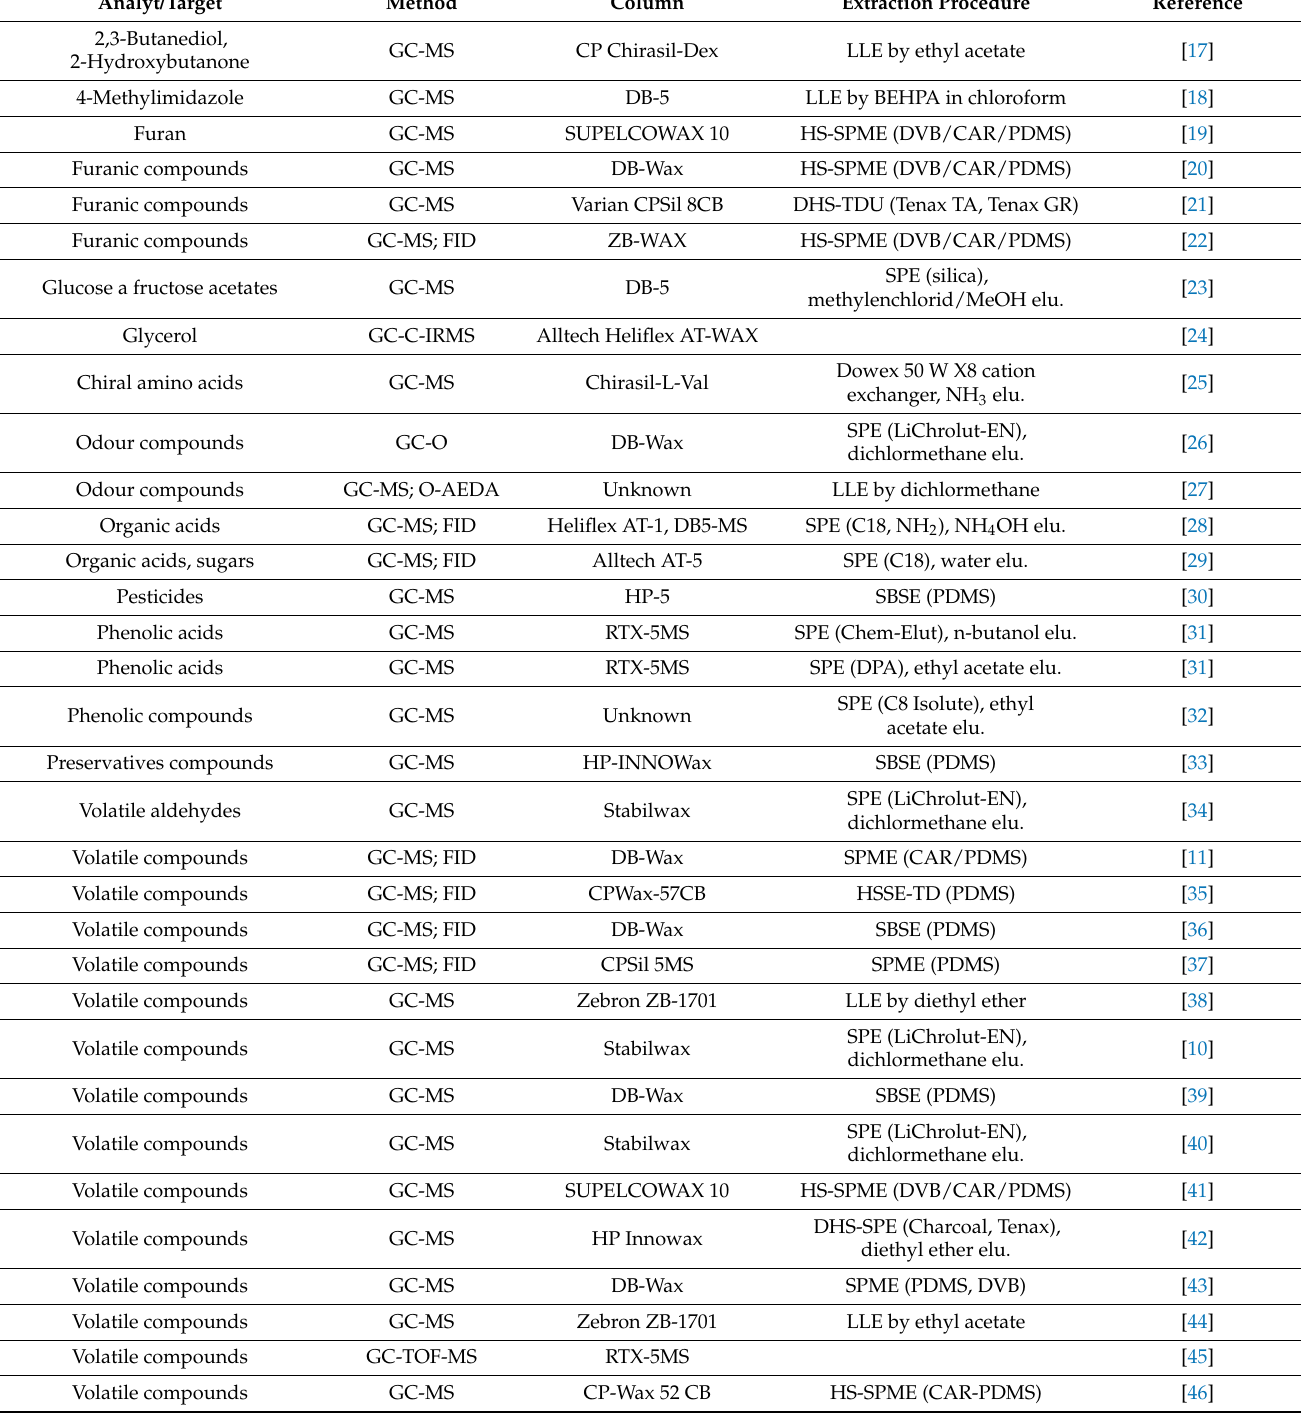
Table 1. Table of methods used for GC analysis of balsamic vinegar